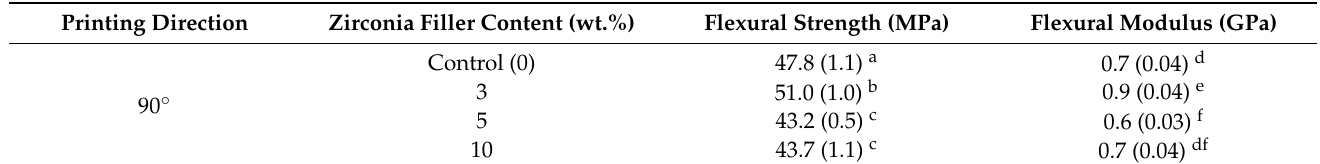
Table 2. Mean (MPa) and SD values of the flexural strengths and moduli for the test groups in the 90 ◦ printing direction.